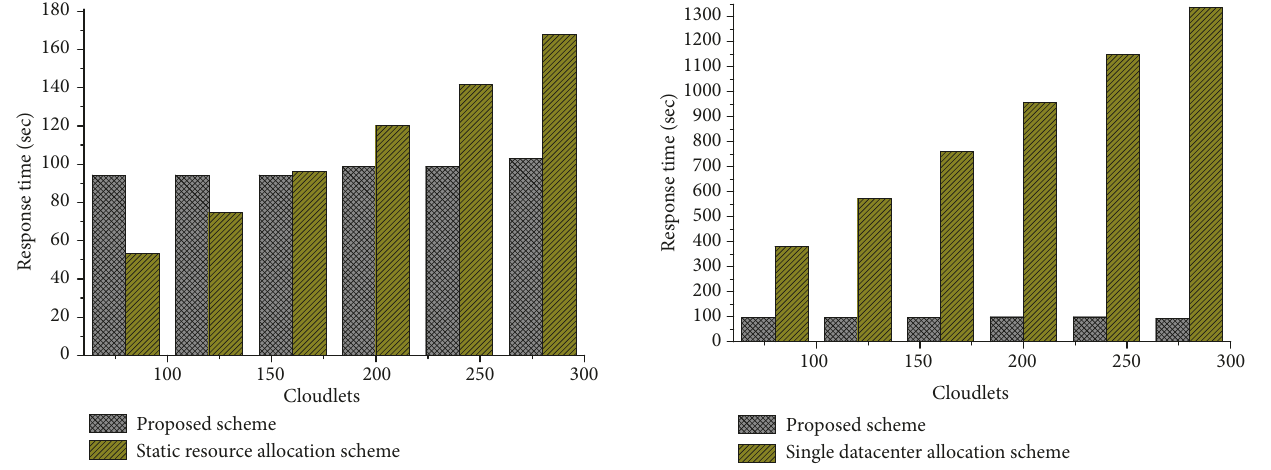
Figure5:Proposedschemevs.thestaticresourceallocationscheme. Figure 6: Proposed scheme vs. the single cluster allocation scheme.